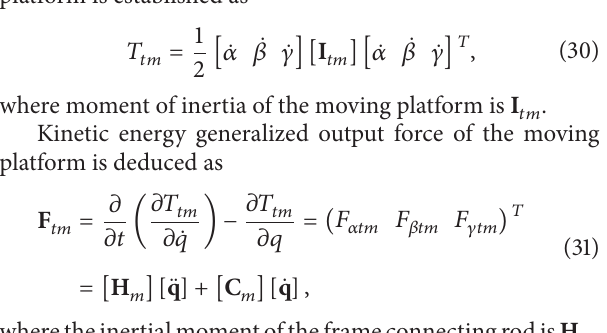
Figure 3: Driving angular velocity curve of